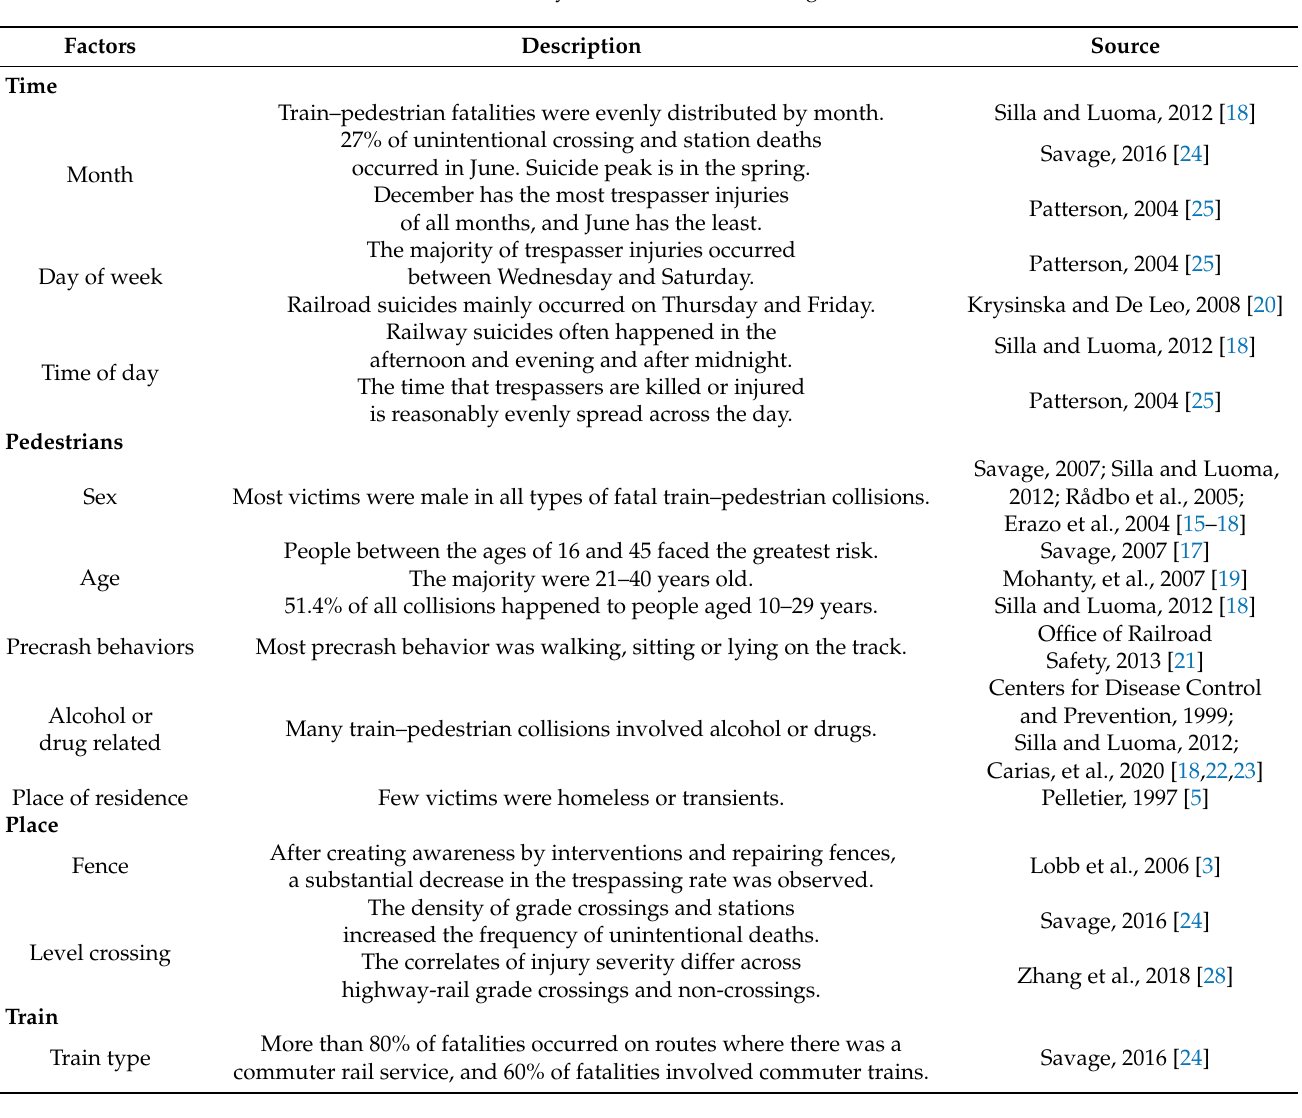
Table 1. Partial summary of studies on influencing